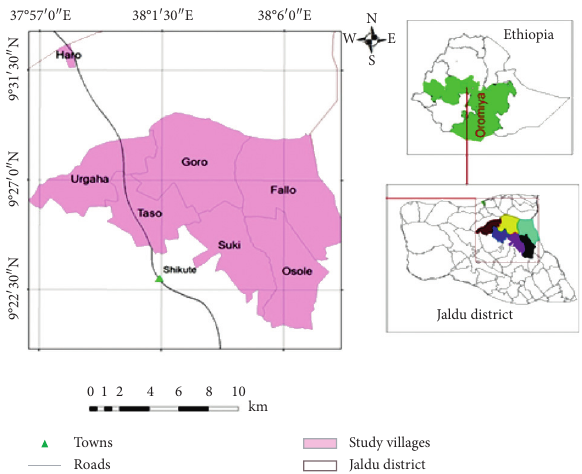
Figure 1: The study area map, Jeldu district, West Shoa,